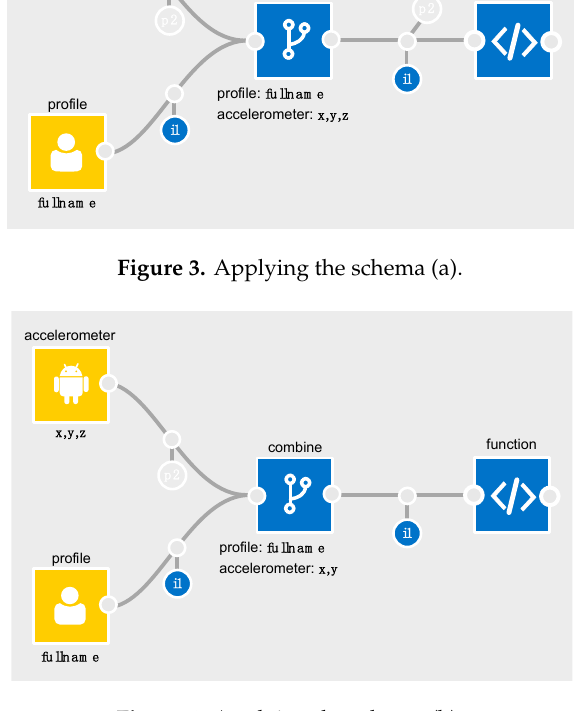
Figure 4. Applying the schema (b).